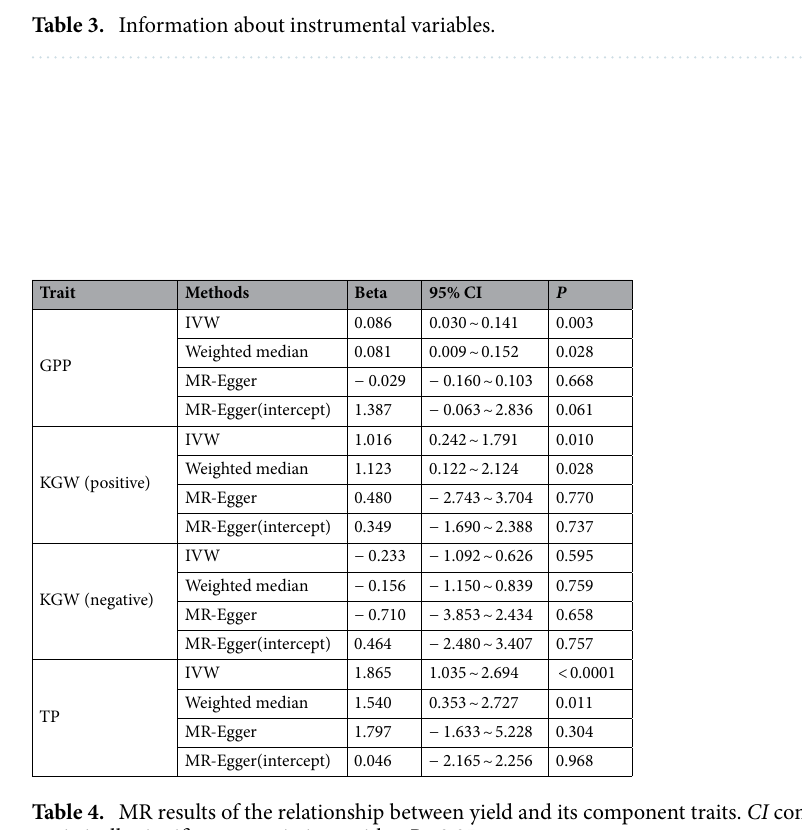
Table 4. MR results of the relationship between yield and its component traits. CI confidence intervals, P statistically significant associations with a P <